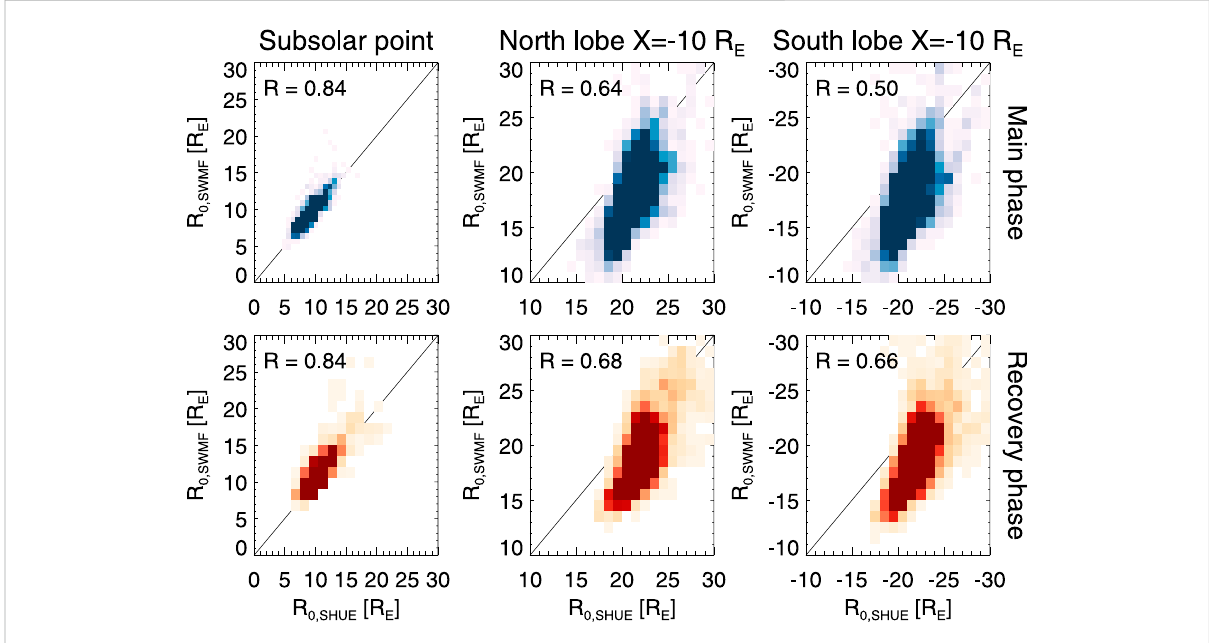
FIGURE 10 SWMF magnetopause location vs. the Shue model. (Left) Magnetopause subsolarposition X -value for Y = Z = 0 . (Middle) North lobe magnetopause position Z -value at Y = 0 , X = - 10 R E . (Right) South lobe magnetopause position Z -value at Y = 0 , X= - 10 R E . (Top row) storm main phase, (Bottom row) storm recovery phase. The heat maps indicate the share of points falling in each